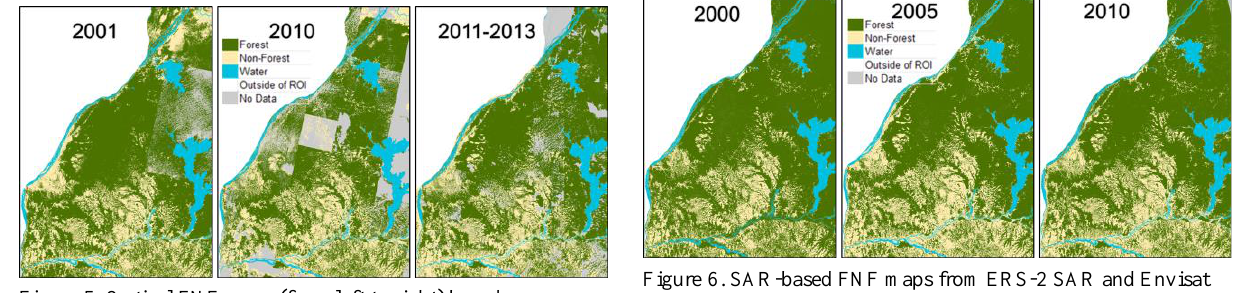
Figure 5. Optical FNF maps (from left to right) based on Lansat-7 ETM+ for 2001, ALOS Avnir-2 for 2010 and RapidEye for 2012.